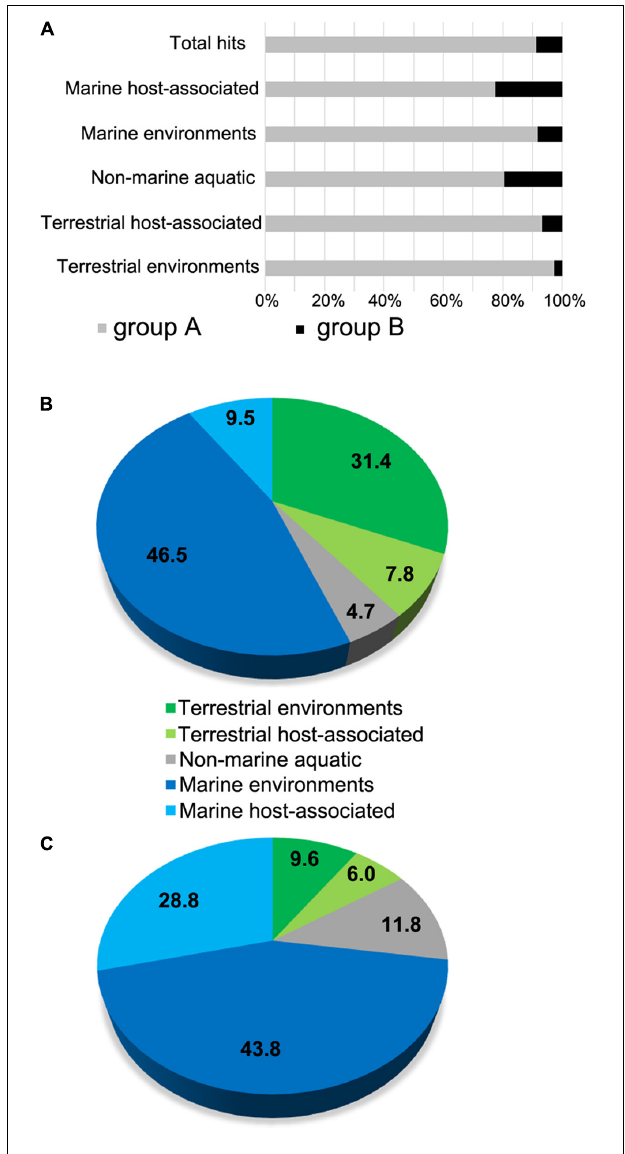
FIGURE 4 | Analysis of environmental distributions of L-2-HAD homologs into IMG/MER metagenome database. (A) Global abundance representation of the DehIVa homologs (group A) and ZgHAD homologs (group B) among L-2-HADs hit number in the full set of IMG/MER metagenomes. (B,C) Distributions of the group A hits (B) and the group B hits (C) sequence hits among five IMG/MER ecosystem